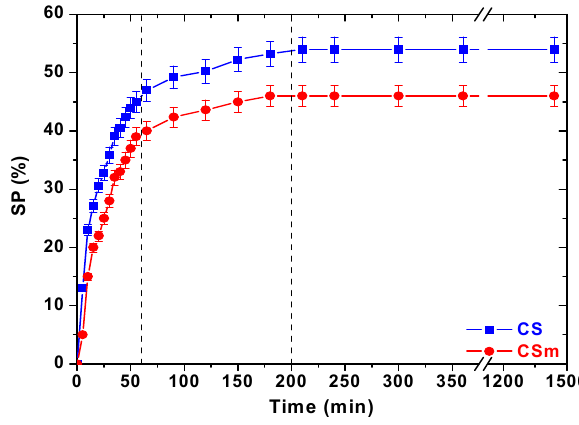
Figure 1. Effect of contact time on swelling